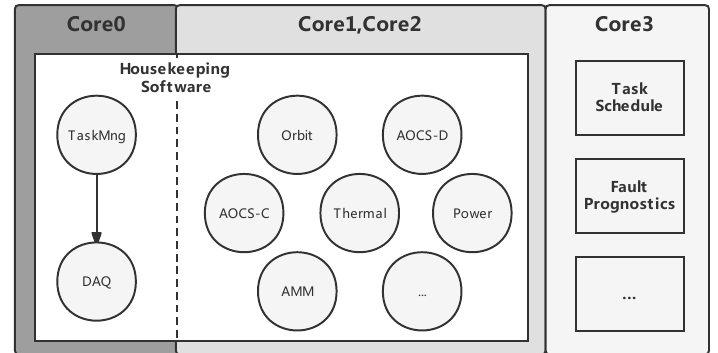
Figure 9. High-performance